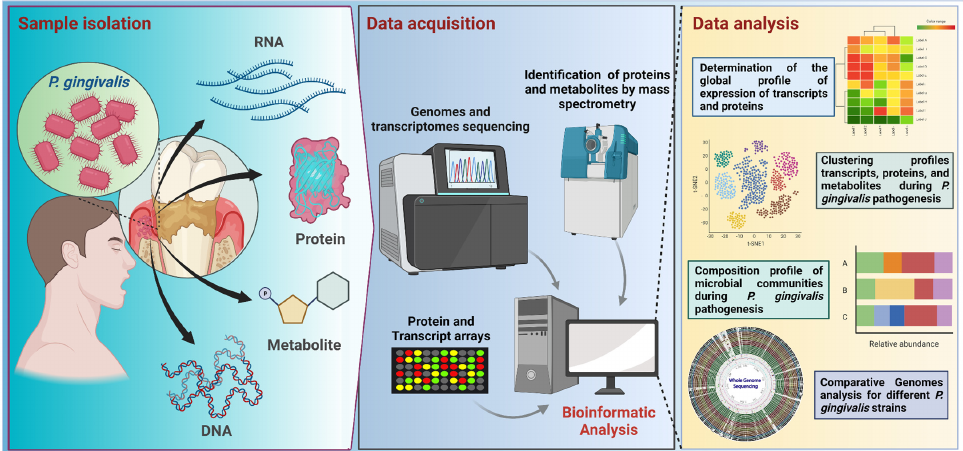
Figure 3. Workflow for − omic research focused on P. gingivalis studies. Samples from subgingival plaque are used for metagenomic, metatranscriptomic, proteomic, and metabolomic analyses. Sam- ples are processed in the data acquisition stage by using sequencing or microarray techniques for DNA and RNA, or by mass spectrometry, used to identify proteins and metabolites. Bioinformatic workflows involve quality control and several downstream analyses, such as data clustering or data classification. For example, in the case of sequencing-based procedures, the analyses start with nucleic acid extraction, purification, quality control, library preparation, and sequencing; raw data from sequencing is analyzed using bioinformatics approaches, depending on the target or strategy for sequencing, such as a marker-targeted amplicon (e.g., a region of the 16S rRNA gene) or a shotgun sequencing (for a whole metagenome). In the case of isolated genome sequencing, generated data can be used in comparative genomic analysis. Transcriptomics studies are directed to RNA samples, involving RNA extraction, isolation, and quality checking, before sequencing. Most transcriptome studies are focused on mRNAs, focusing on the identification of the upregulated and downregulated gene expression. The further analysis comprises the determination of the global expression profile, clustering profile, and community composition profile. This figure was created using